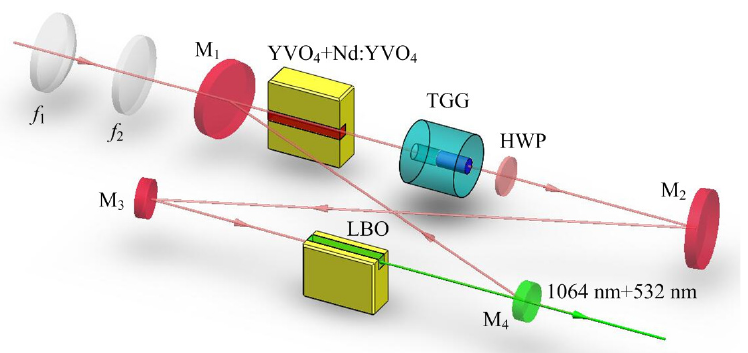
Figure 2. Schematic of the single-end laser-diode-pumped laser [21]. Reprinted with permission from [21] c (cid:13) The Optical